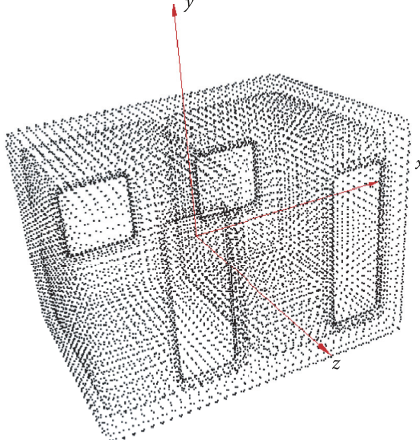
Figure 1: The geometry of the building.